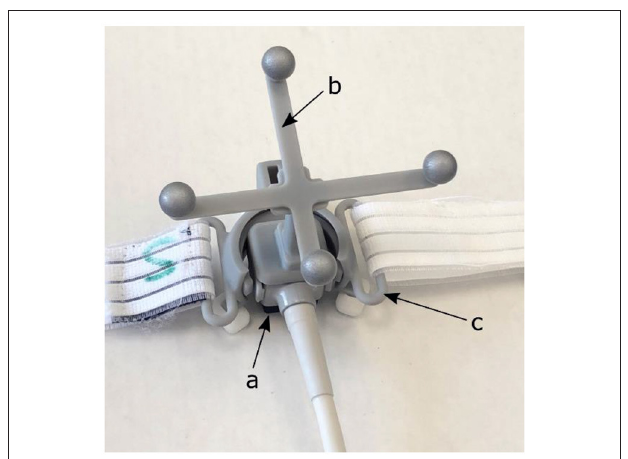
FIGURE 1 | Prototype version of the EBAMed proprietary US probe system (a) equipped with an optical localization marker (b) and a probe holder with strap (c) that allows for fixation to the patient’s